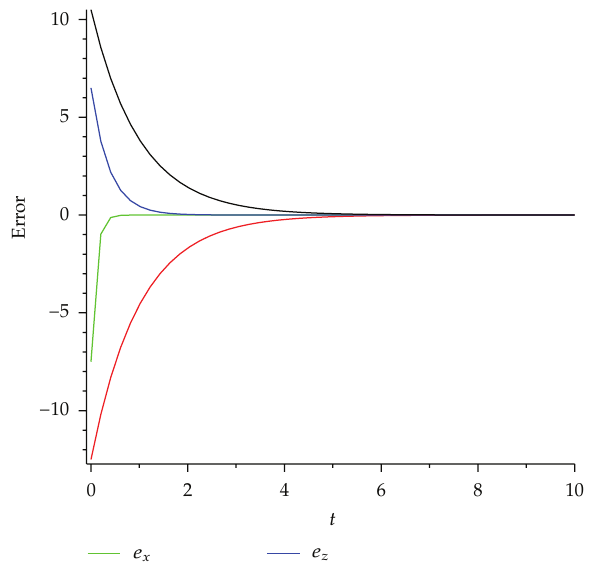
Figure 13: It shows that the behaviour of the trajectories e x ,e y ,e z , and e w of the error system between hyperchaotic Lorenz system and hyperchaotic L¨u system tends to zero as t tends to 5 when the scaling factor α (cid:8) 5.